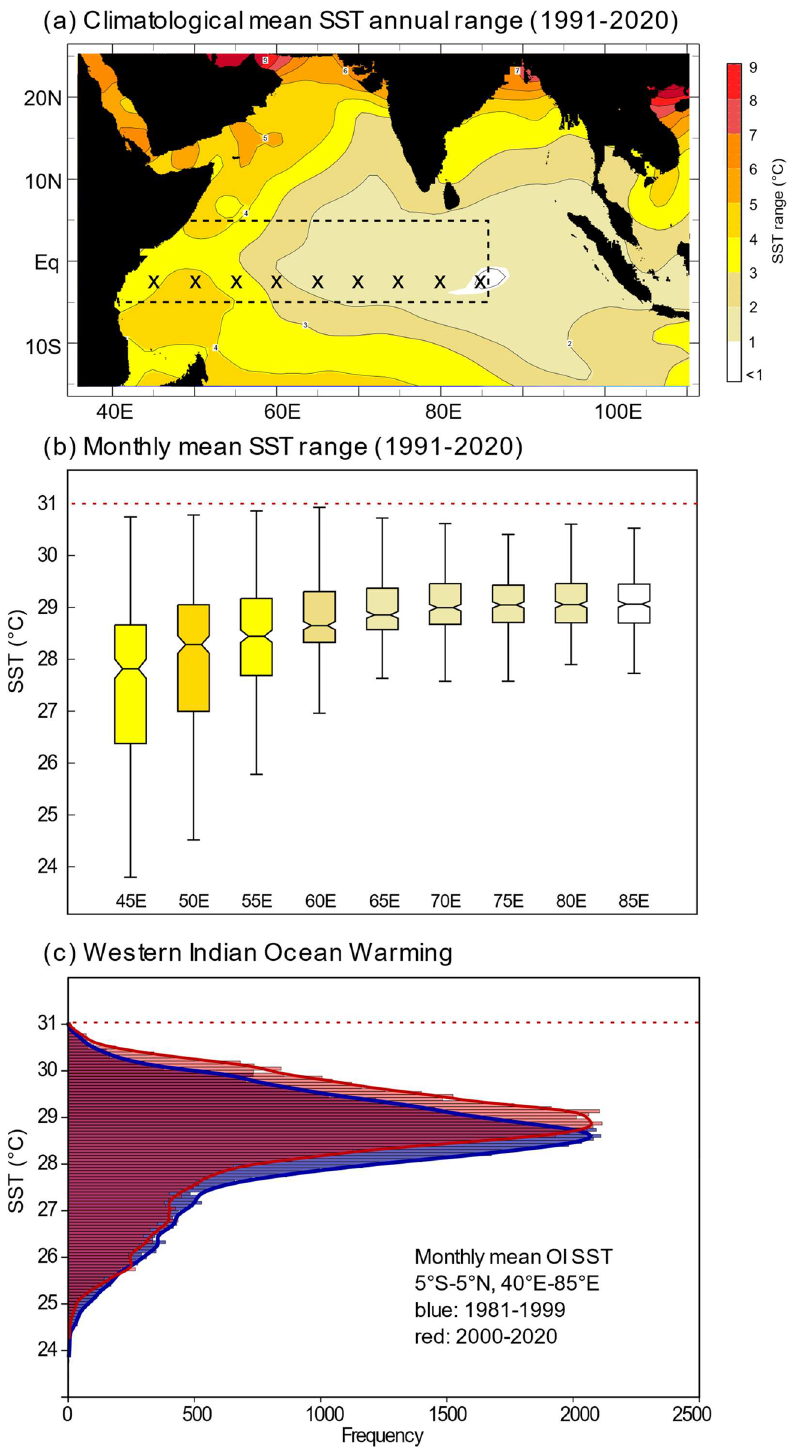
Figure 2. SST seasonality, range and warming in the WIO. ( a ) Map showing SST climatology in the Indian Ocean for the time period 1991–2020. SST data is taken from AVHRR SST 25 . Chart computed at IRI/LDEO Climate Data Library (http:// iridl. ldeo. colum bia. edu). Date accessed: 31 March 2021. ( b ) Boxplots showing range of monthly mean SSTs (AVHRR SST 25 , 1991–2020) in the WIO (grids where data was taken are marked with an ‘x’ in a ). Boxplots show the median (horizontal line and notches), interquartile range and maximum/minimum values of monthly mean SST as whiskers. Maximum SSTs do not exceed 31 °C. Minimum SSTs are lowest in the path of the SW monsoon jet. ( c ) Histogram comparing the distribution of monthly mean AVHRR SSTs 25 in the WIO (data was taken from area marked with dashed rectangle in a ) for the time period 1981–1999 and 2000–2020. Note the shift towards warmer SSTs in the latter period and the rapid drop at 30–31 °C. AVHRR SST 25 data was obtained from the IRI/LDEO Climate Data Library (http:// iridl. ldeo. colum bia. edu). Date accessed: 31 March